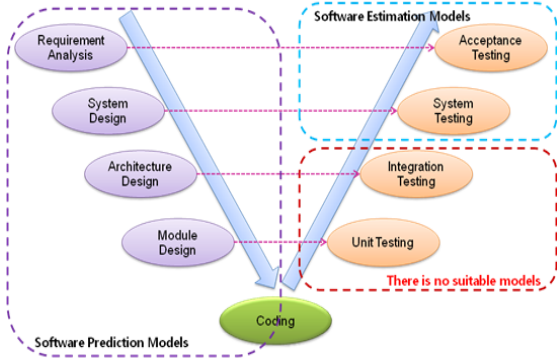
Fig. 3. Software Reliability Models on